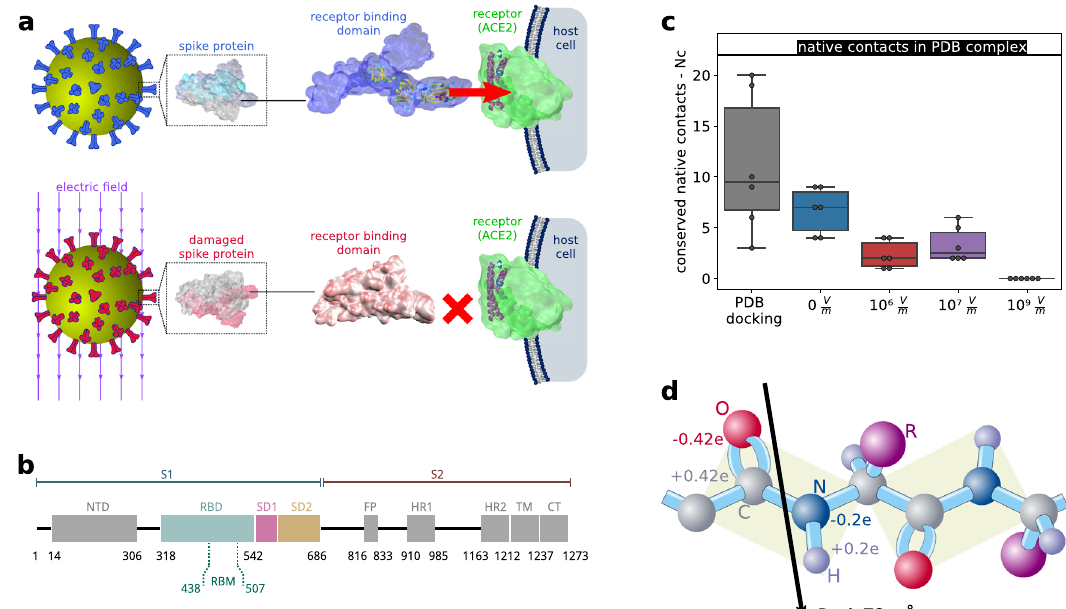
Fig. 1 External electric fi elds affect the attachment of SARS-Cov-2 to the host cell. a Virus entry into the cell is mediated by the recognition between the spike glycoprotein (S protein) present in the virus envelope and the angiotensin-converting-enzyme receptor (ACE2) of the host cell membrane. The binding between the S protein and ACE2 can be altered when external electric fi elds induce drastic conformational changes and damage in the S protein. b Sequence of the S protein (PDB IDs: 6VSB and 6M0J 1, 19 ). Highlighted in colours is the segment used in this study. c Conserved number of native contacts (N C ) between residues of S and ACE2 for different magnitudes of the EF strength. N C is maximal for native S protein. Very strong electric fi elds (10 9 V/m) disable the protein by largely deforming its shape, leaving a structure which is unrecognised by ACE2 (N C = 0). Moderate electric fi elds, which can be induced by available industrial or laboratory devices 71 , strongly reduce N C and are therefore candidates to decrease the af fi nity of S to ACE2 and, consequently, the infectivity of the virus. The best 6 matches (higher Nc) are taken for each condition for comparison. In the box-whisker plot, the central line indicates median, box limits indicate upper and lower quartiles, and whiskers specify maxima and minima. Source data are provided with this paper. d Changes in the structural conformation of proteins under EF are driven by reorientation of electric